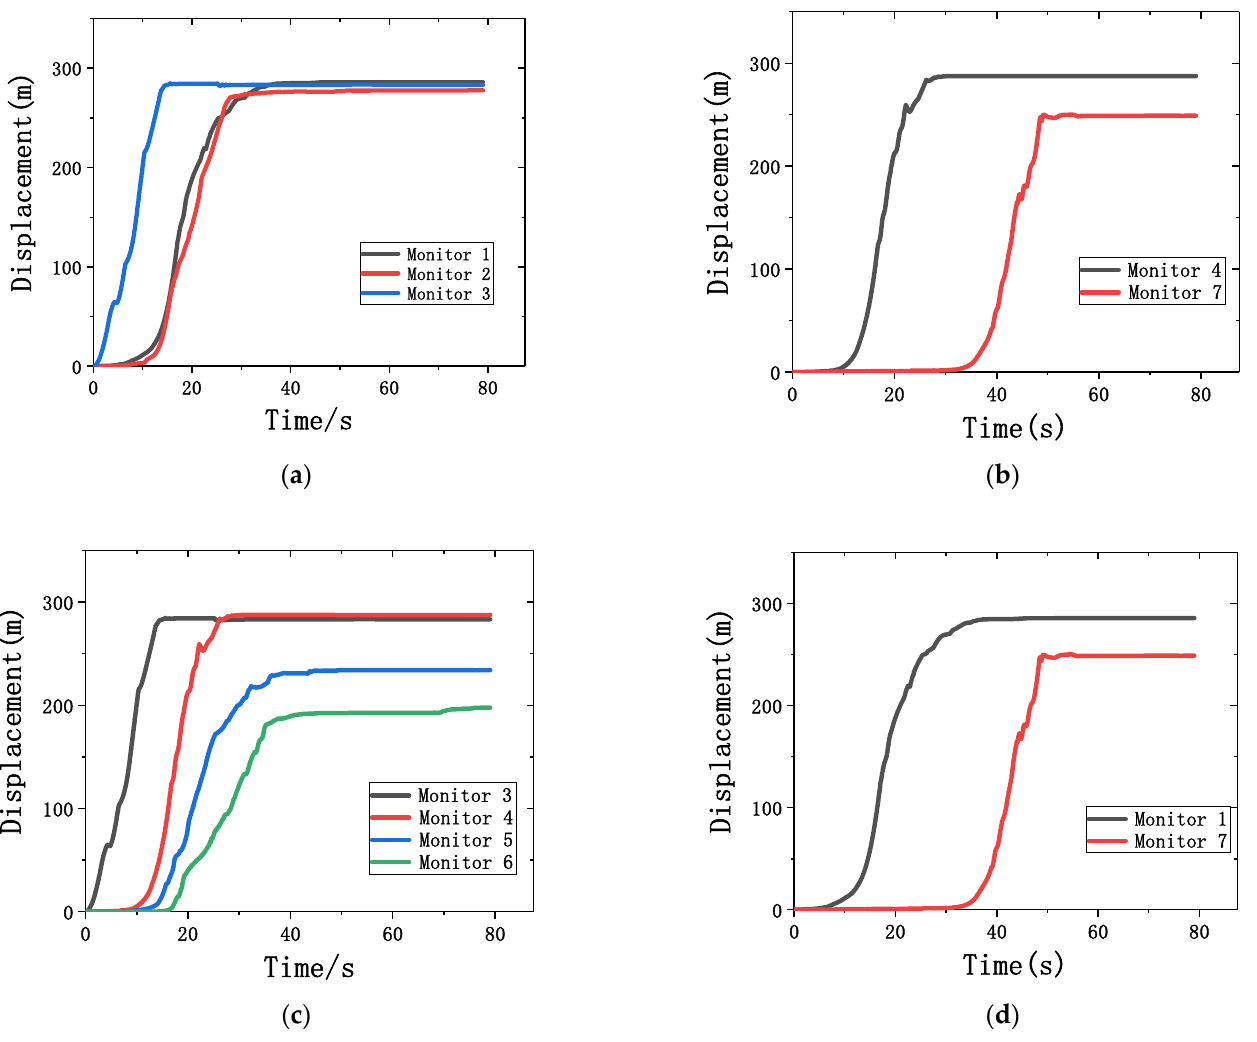
Figure 17. Time history curves of displacement of monitors under the EW seismic wave loading. Horizontally arranged monitors 1/2/3 ( a ) and 4/7 ( b ); longitudinally arranged monitors 3/4/5/6 ( c ) and 1/7 ( d ).